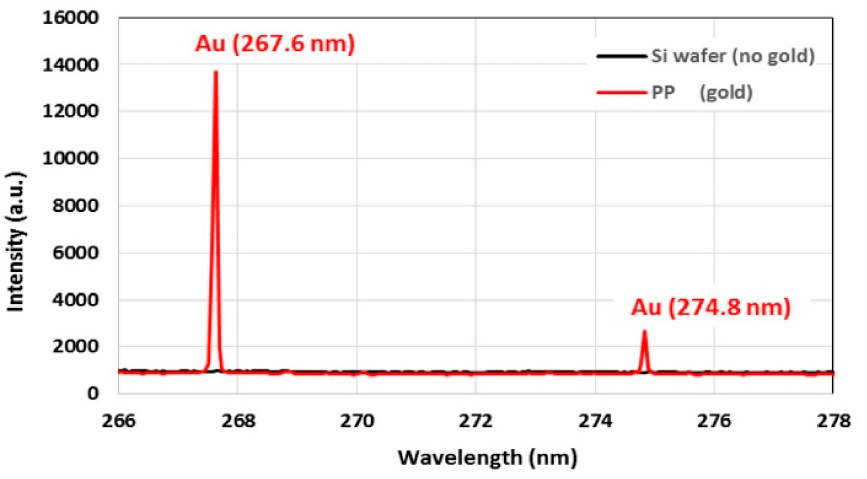
Figure 3. The LIBS intensity of PP coated substrate incubated with gold ions (red) and uncoated substrate without gold used as control sample